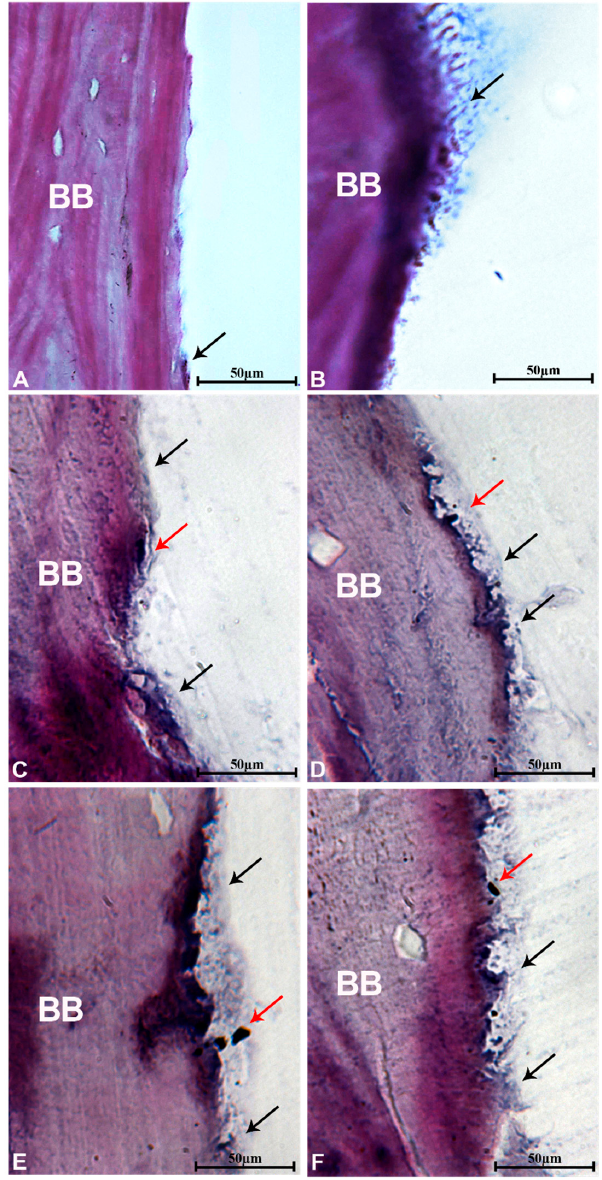
Figure 6. ( A – F ) Histological evaluation: ( A ) Histologic section of bone block ( B ) seeded with hDPSC. The sample showed a discontinuous cell layer (arrow) (toluidine blue and acid fuchsin, 1000 × ). ( B ) Histologic section of bone block ( B ) seeded with hDPSC and melatonin. The sample showed a continuous cell layer (arrow). (Toluidine blue and acid fuchsin, 1000 × ). ( C ) Histologic section of G-N2-coated bone block ( B ) seeded with hDPSC. The sample showed a discontinuous cell layer (black arrows); in a small portion, a residue of graphene G-N2 (red arrow) was detected. (Toluidine blue and acid fuchsin 1000 × ). ( D ) Histologic section of G-N2-coated bone block ( B ) seeded with hDPSC and melatonin. The sample showed a continuous cell layer (black arrows) and in one point a thick residue of G-N was observed (red arrow) (toluidine blue and acid fuchsin, 1000 × ). ( E ) Histologic section of G-N10-coated bone block ( B ) seeded with hDPSC. G-N particles (red arrow) appeared both in contact and distant from the block surface. In some areas (black arrows) cells on the surface could be observed. (Toluidine blue and acid fuchsin, 1000 × ). ( F ) Histologic section of G-10-coated bone block ( B ) seeded with hDPSC and melatonin. G-N particles were present in contact (red arrow) with the surface and a thin cellular layer (black arrow) on the surface was present (toluidine blue and acid fuchsin, 1000 ×